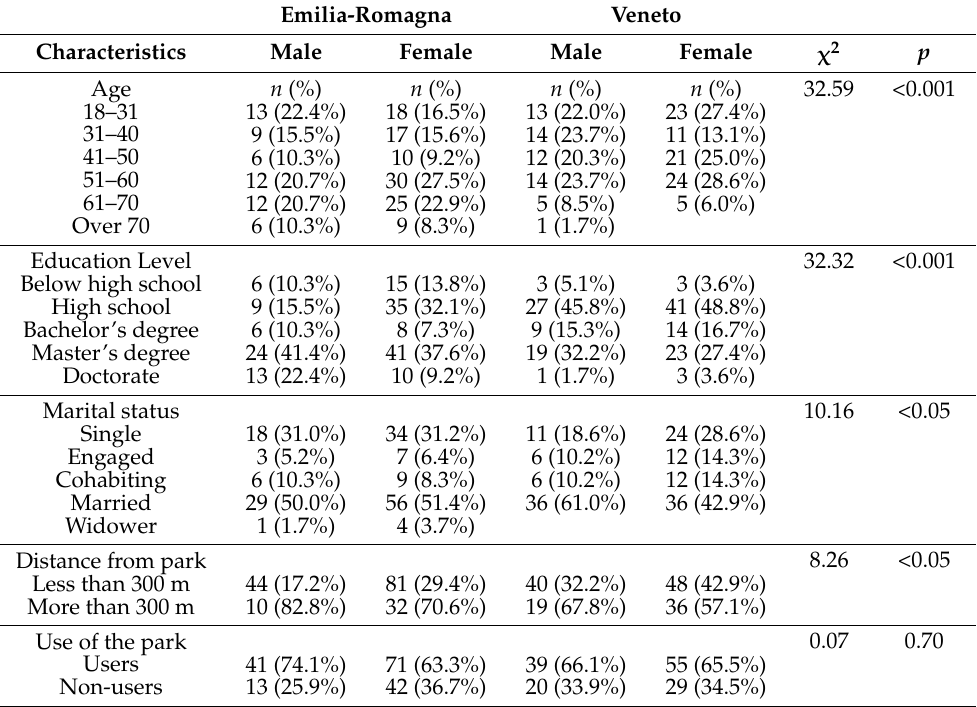
Table 2. Demographic characteristics of participants ( n = 310) and Chi-square test between the frequencies of the two regions. Emilia-Romagna Veneto